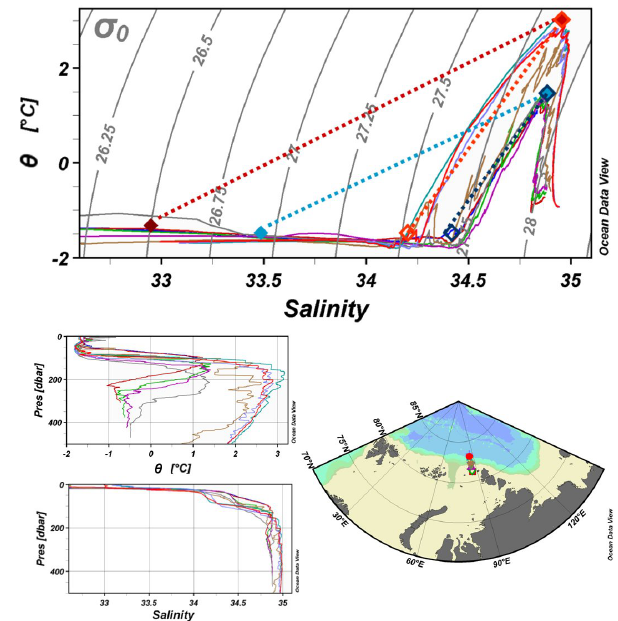
Fig. 7. Potential temperature and salinity profiles and θS diagrams showing the difference of the winter mixed layers and the Atlantic cores of the Fram Strait branch (red) and the Barents Sea branch (blue). In spite of having a cooler and less saline Atlantic layer the winter mixed layer of the Barents Sea branch, created by stirring melt water into the upper part of the Atlantic water, is more saline than that of the Fram Strait branch. The filled diamonds indicate the salinity of the mixed layer if all oceanic heat is going to ice melt, the open diamonds the salinity if minimum heat is going to ice melt based on the temperature and salinity of the Atlantic